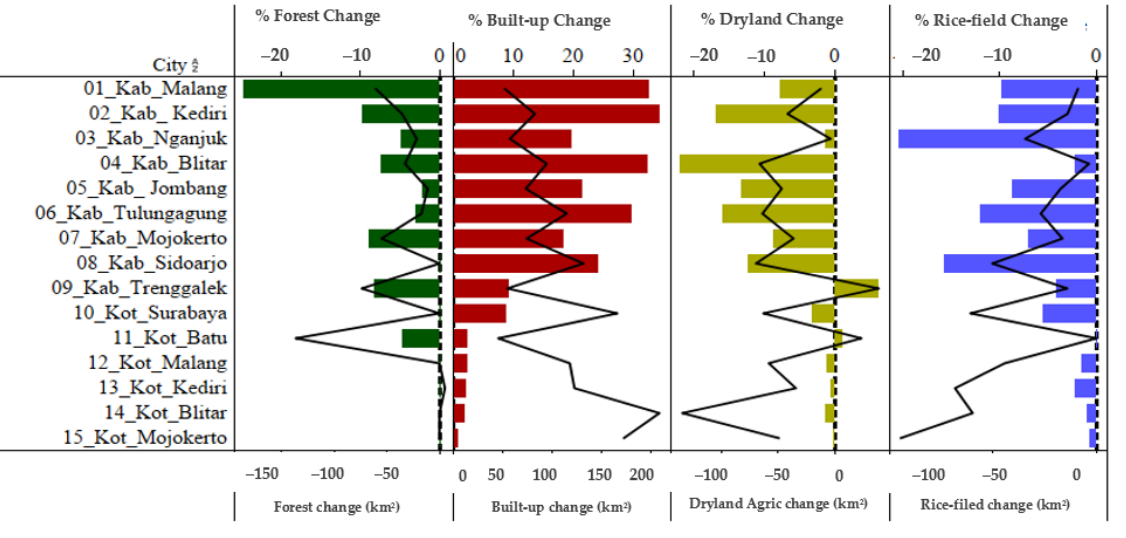
Figure 5. City-wise changes in land-use during 1995 – 2015. The black line is the change relative to the city’s size (%), and the bars are the magnitude of changes (km 2 ). The cities are ordered based on their size.